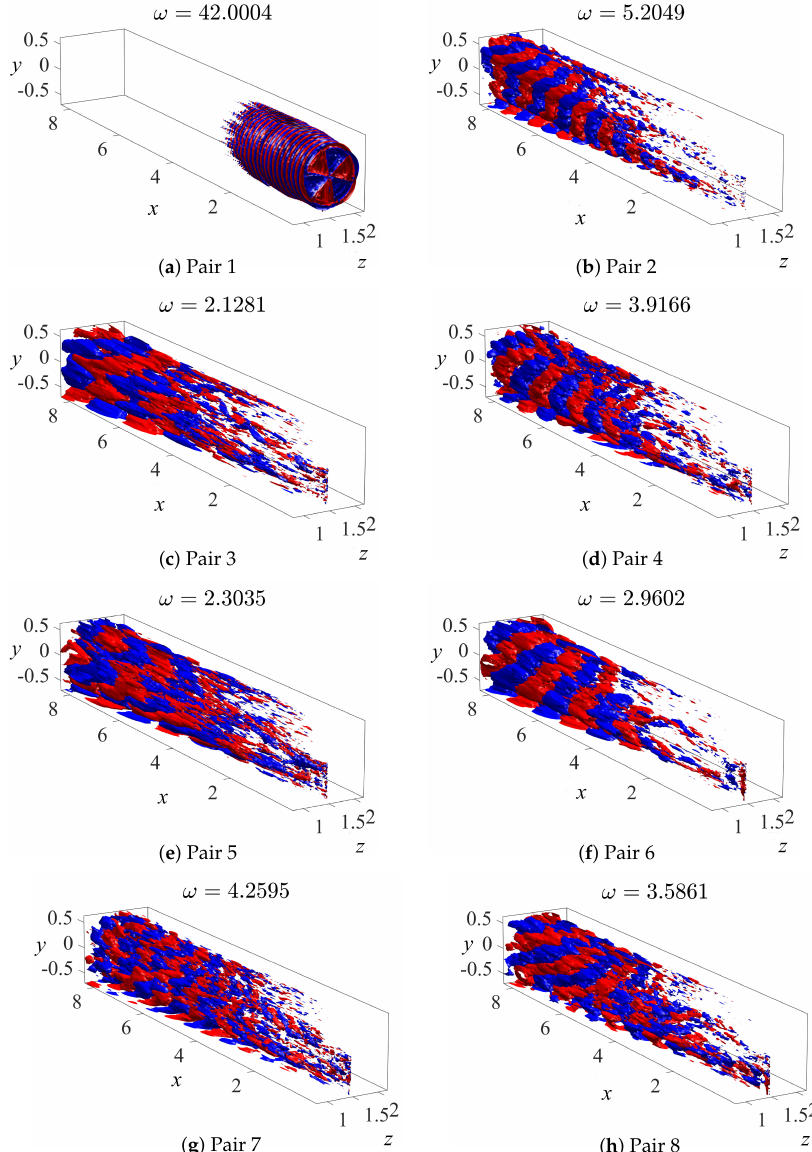
Figure 9. Streamwise velocity iso-surfaces (red for u = 0.001, blue for u = − 0.001 values) of the real part of the eight dynamic modes’ pairs selected by the sparsity-promoting algorithm, ordered according to their amplitude | α |